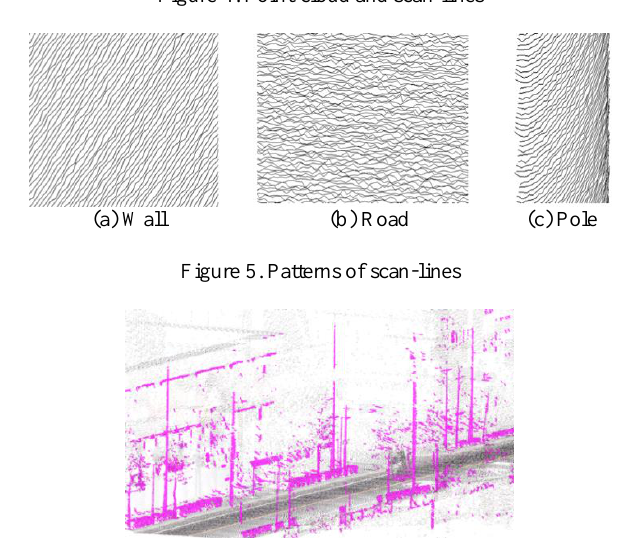
Figure 6. Selection of candidate